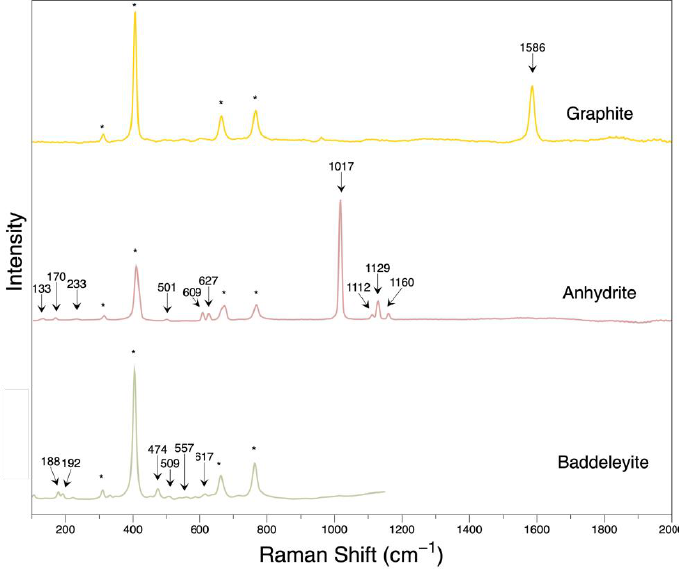
Figure 6. Representative Raman spectra are shown for mineral inclusions analyzed in our samples. Peaks in the inclusion spectra that are marked with an asterisk (*) are from the host spinel. All the spectra are stacked for clarity.